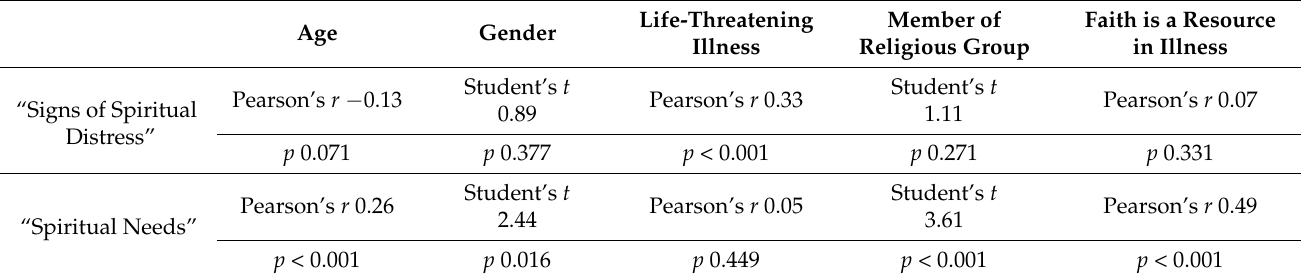
Table 4. Correlation analysis between dependent and independent variables.